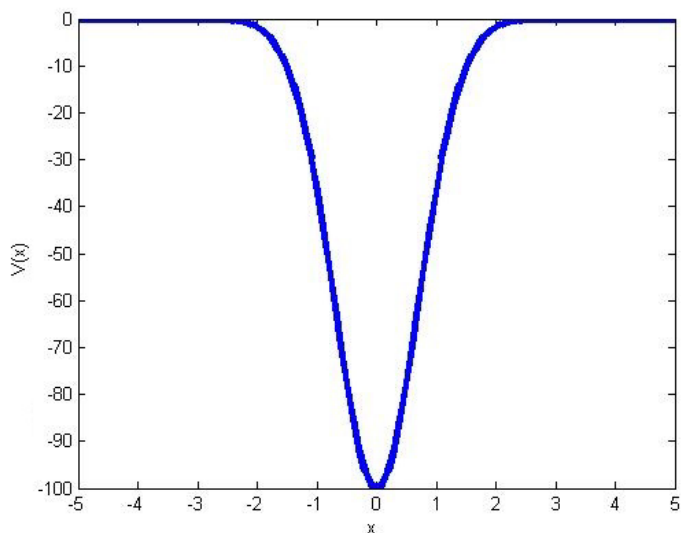
Figure 11. Variation of V ( x ) (Equation (18)) with x .